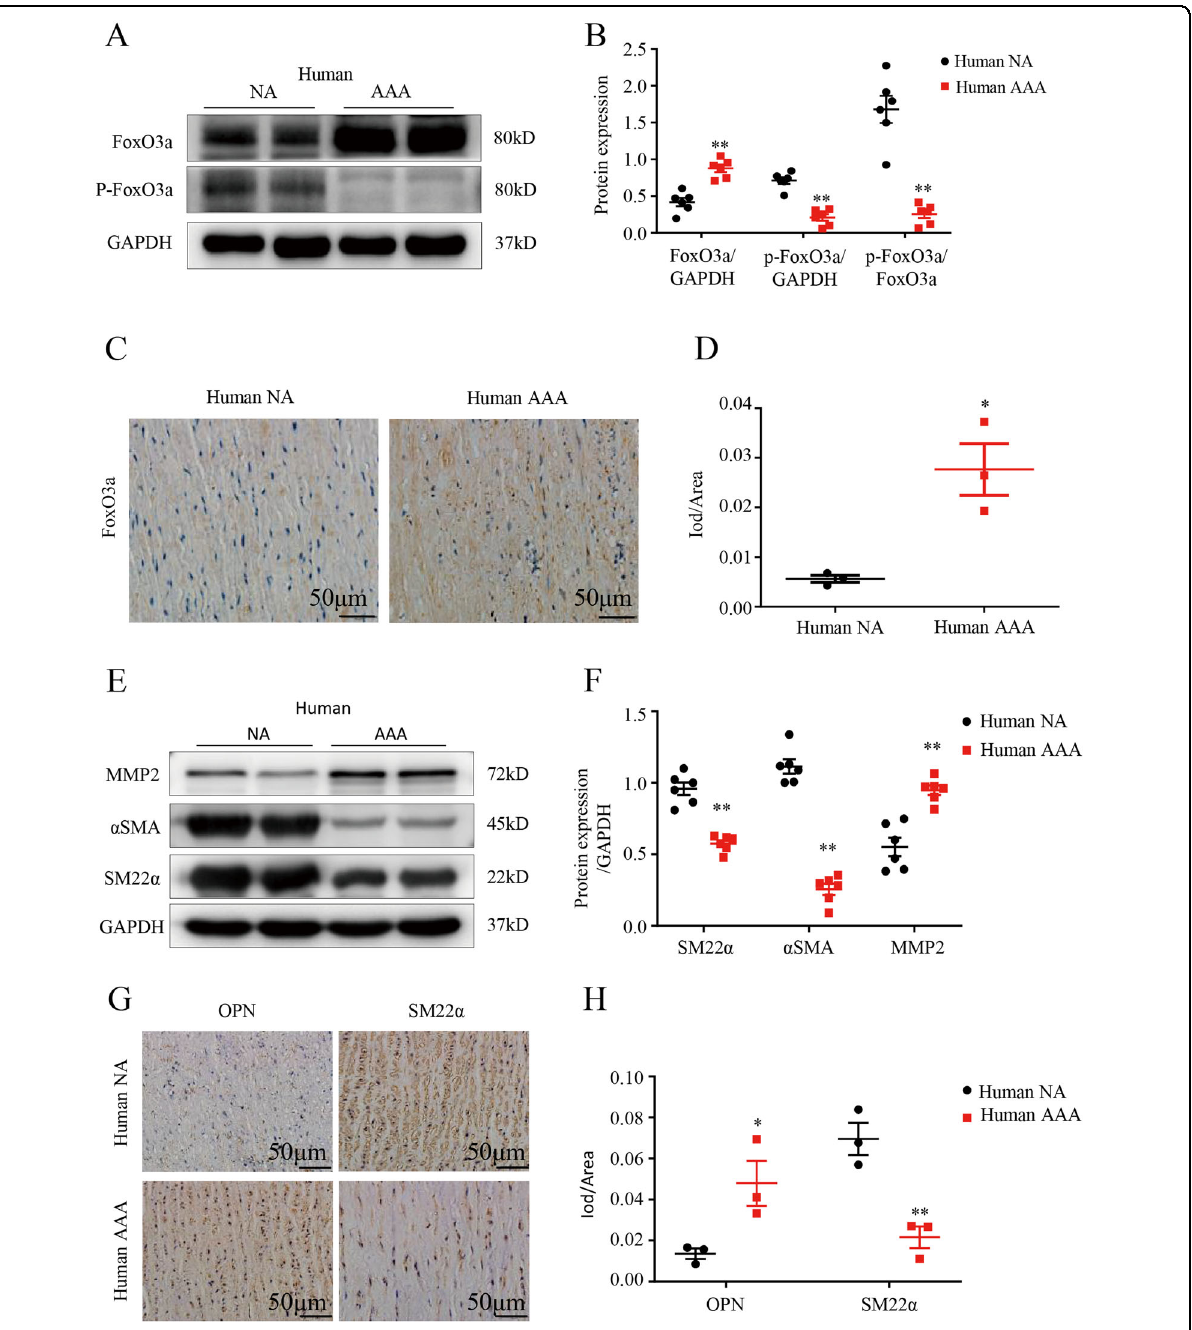
Fig. 1 FoxO3a is upregulated in human tissues and the VSMC phenotypic switch occurs during abdominal aortic aneurysm (AAA) formation. A and B Western blots (WB) and densitometric analysis of the protein levels of Forkhead box class O3a (FoxO3a) and phospho Forkhead box class O3a (p-FoxO3a) in human AAA samples and adjacent nonaneurysmal aortic sections (male; n = 6). C and D Representative FoxO3a staining in human AAA samples and adjacent control aortas (scale bars = 50 µm, male; n = 3). E and F WB and densitometric analysis of the protein levels of α -smooth muscle actin ( α -SMA), matrix metalloproteinase (MMP2) and smooth muscle 22 α (SM22 α ) in human AAA samples and adjacent nonaneurysmal aortic sections (male; n = 6). G and H Representative staining with osteopontin (OPN) and SM22 α in human AAA samples and adjacent control aortas (scale bars = 50 µm, male; n = 3). Data are presented as the mean ± SE. * p < 0.05, ** p < 0.01. NA indicates nonaneurysmal